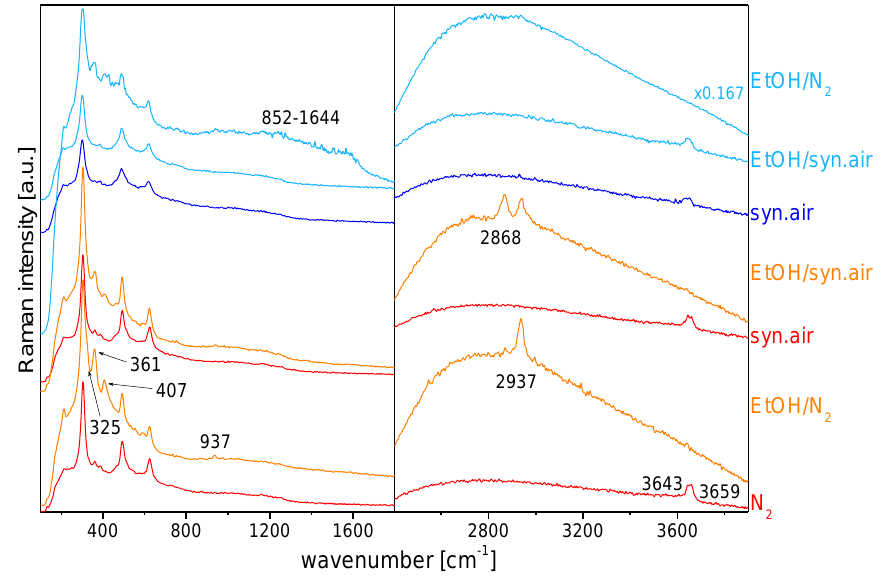
Figure 7. Operando Raman spectra (at 514.5 nm excitation) of the ethanol gas sensing of indium oxide at 190 °C (red/orange) and 325 °C (blue). Spectra are offset for clarity. Modified from [5].